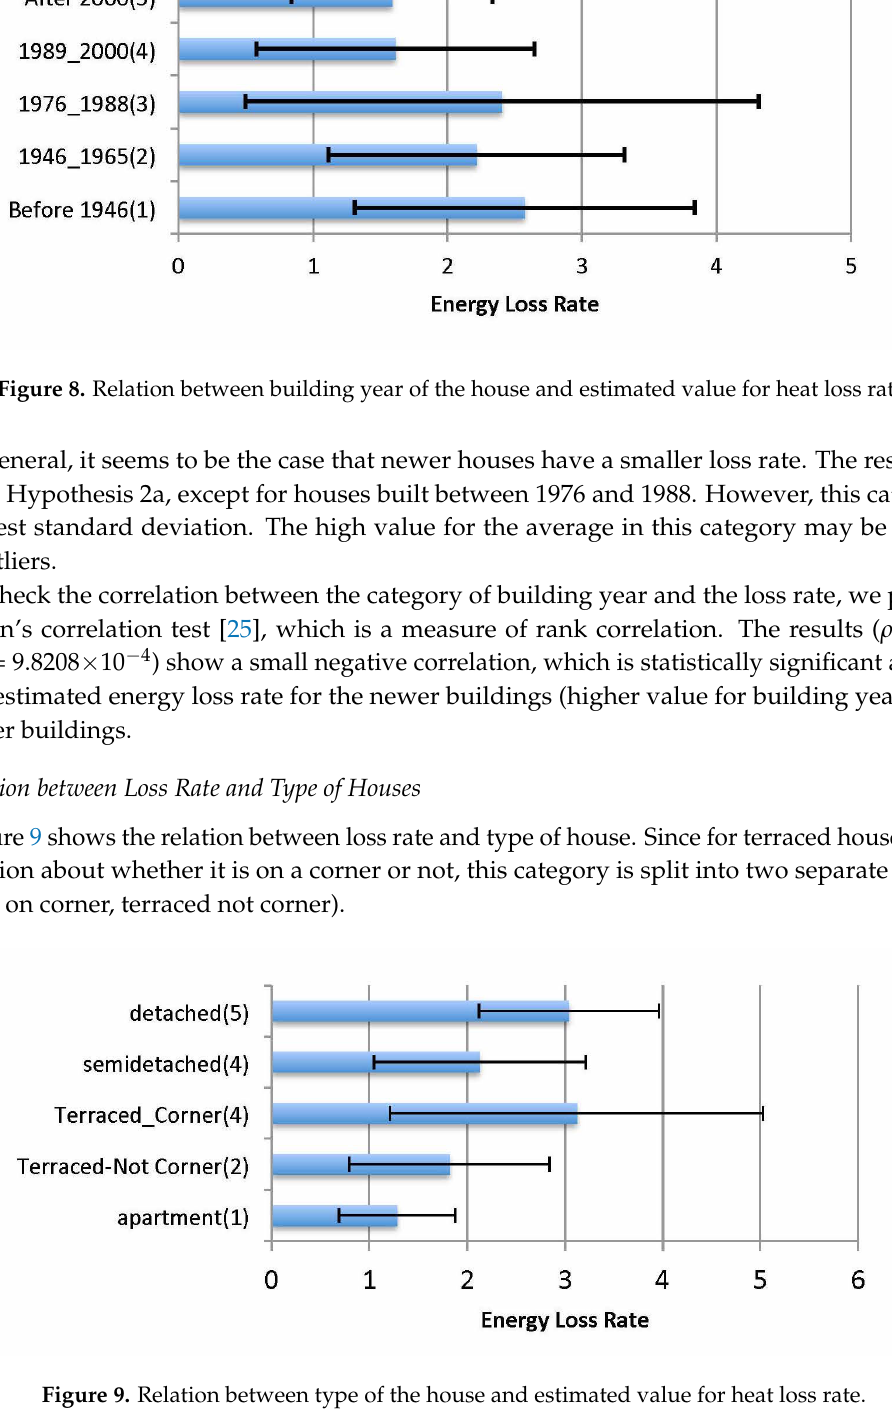
Figure 9. Relation between type of the house and estimated value for heat loss